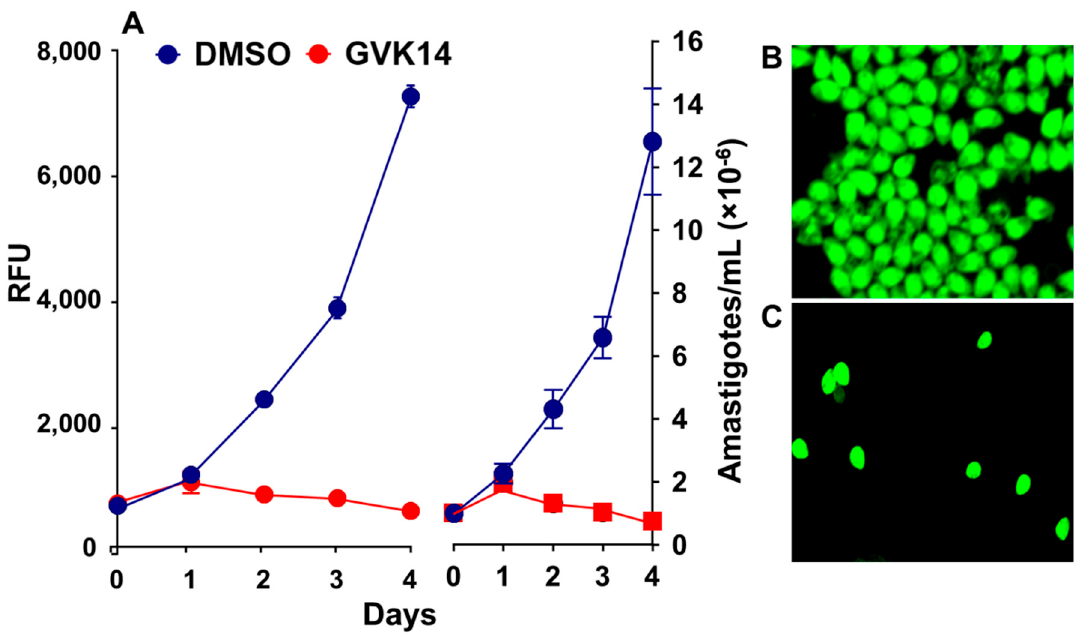
Figure 5. Inhibitor effects on the axenic growth of cloned amastigotes-GFP in cell-free medium. ( A ) Effects of GVK14 on the growth of cloned amastigotes-GFP evaluated by RFUs. ( B , C ) Growth of amastigotes-GFP treated with DMSO and GVK14 was evaluated microscopically.